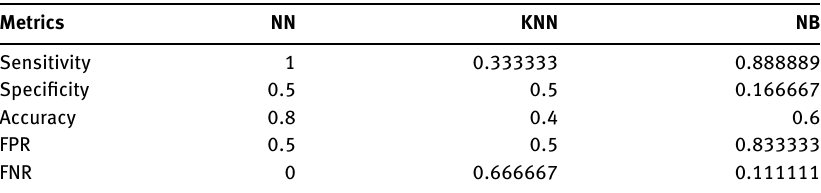
Table 2: Sensitivity, Specificity, Accuracy, FPR, and FNR Values for the Classification Result for Different Food Images.